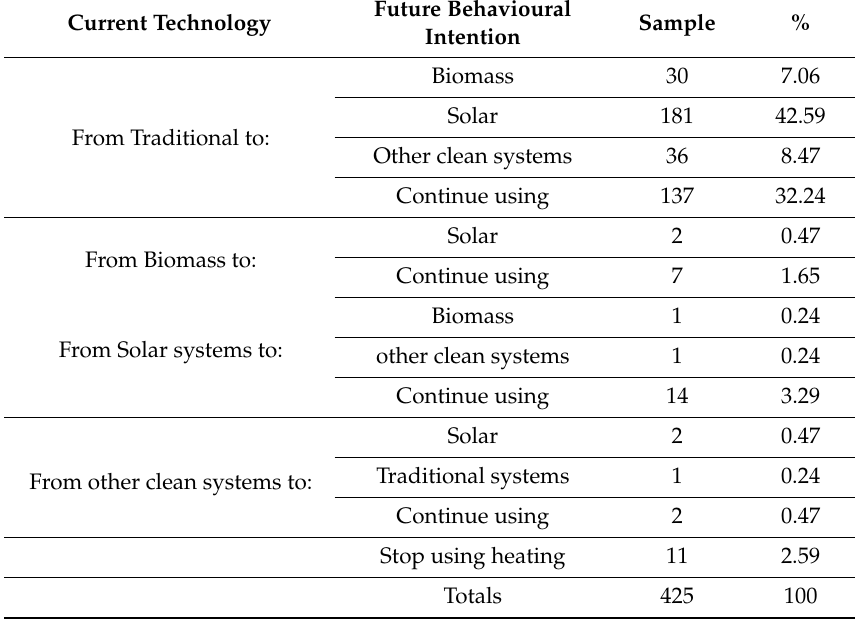
Table 3. Respondents’ future behavioural